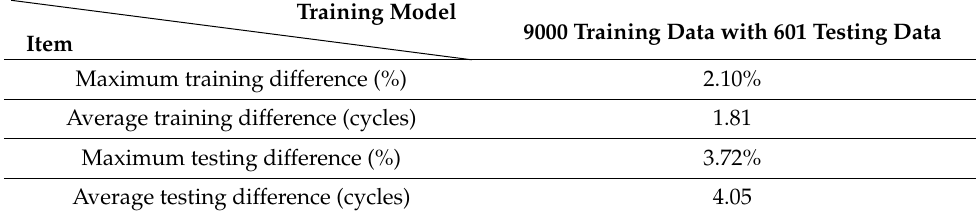
Table 15. The performance of the K-K model in K =